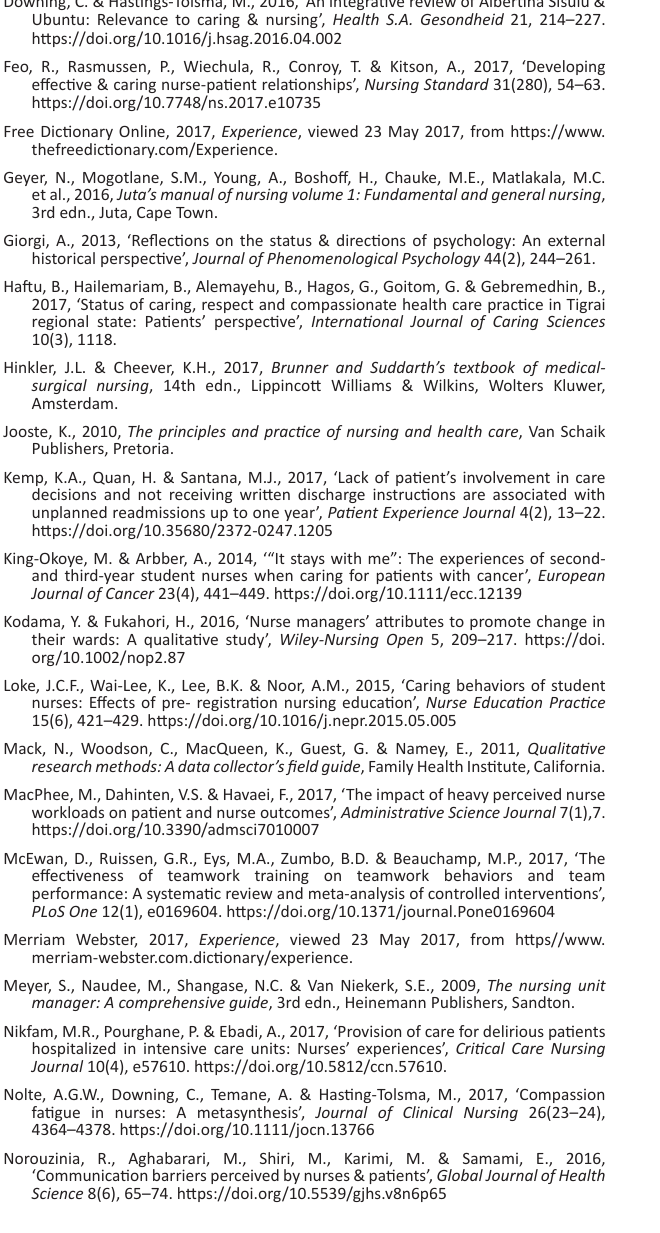
Lacerda: Case report’, Rev Gaucha Enferm 37(3), e58271. https://doi.org/ 10.1590/1983-1447.2016.03.58271 South African Nursing Council, Regulation 425, 1985, Notification of training of leading to registration as a nurse (general, psychiatric and community) and midwife , Government Notice No R425 of 22 February 1985, as amended, Government Printers,